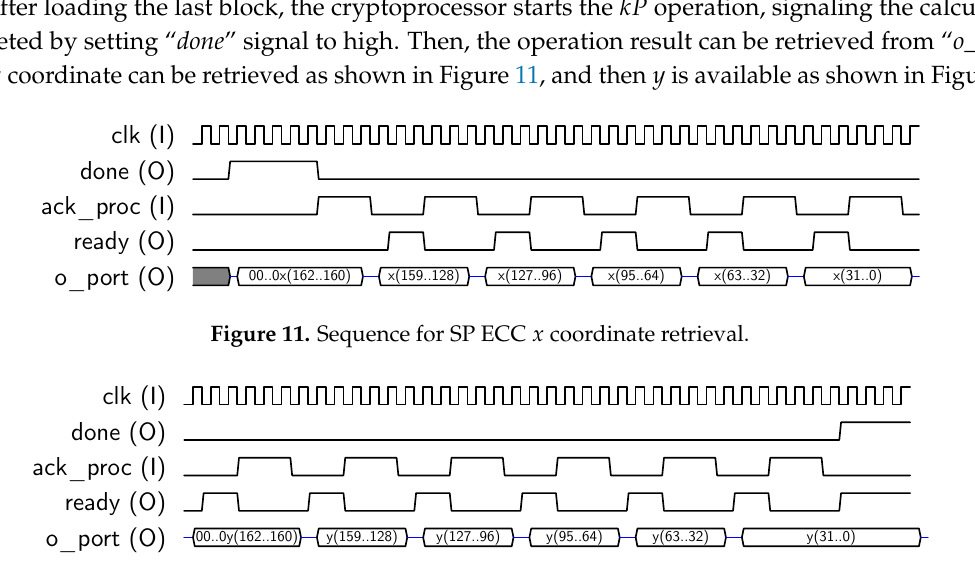
Figure 12. Sequence for SP ECC y coordinate